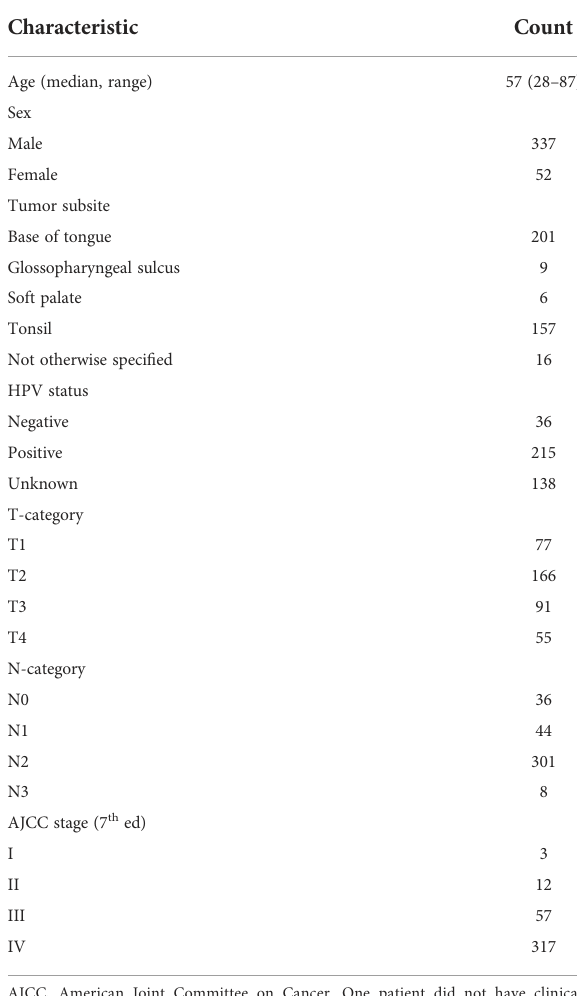
TABLE 1 Clinical demographics of patients whose data were used in this study.